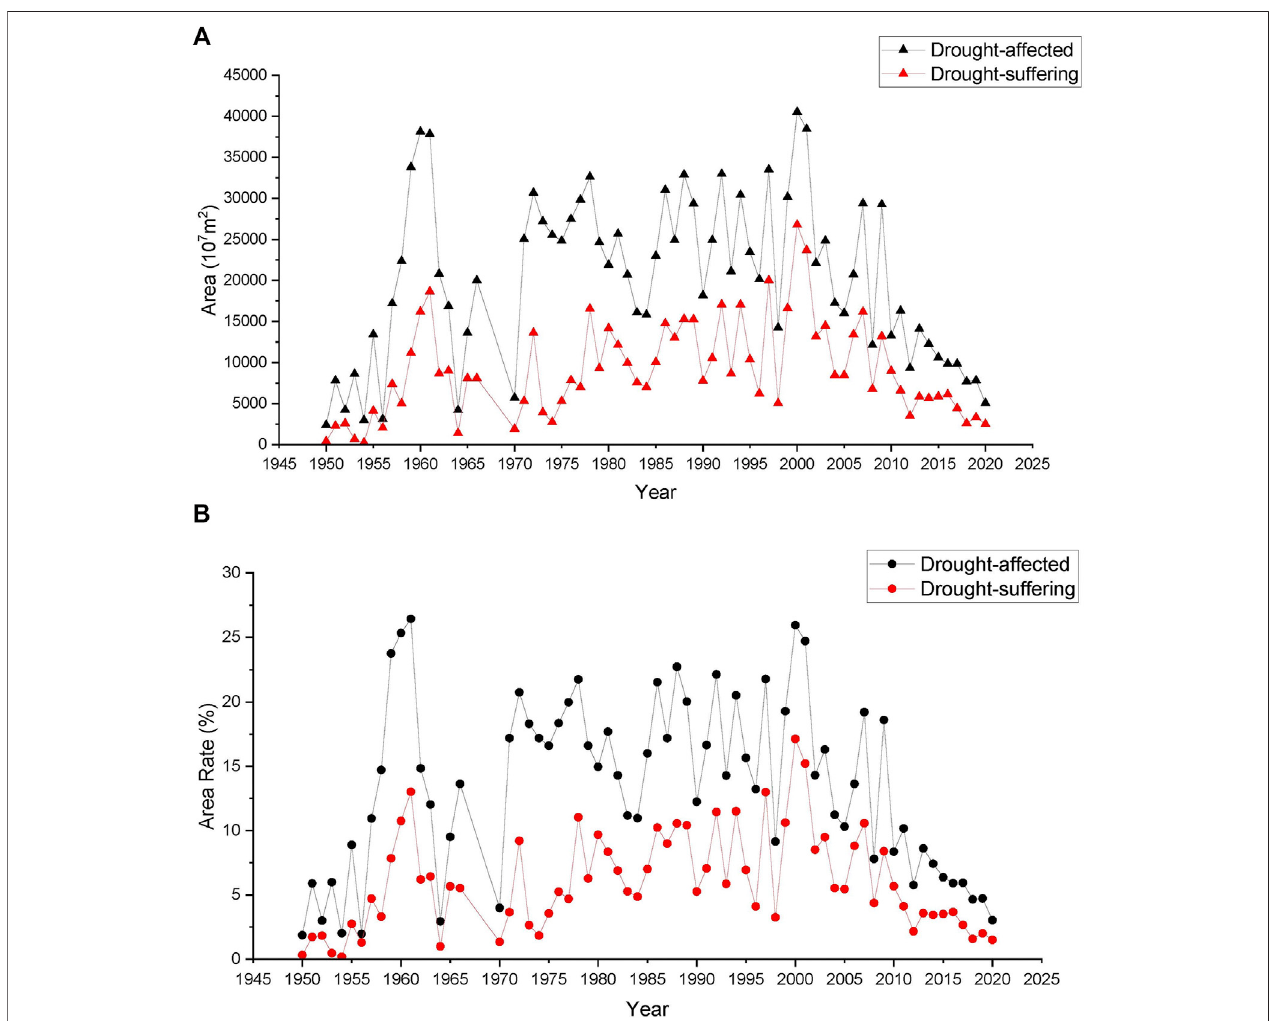
FIGURE 1 | Temporal variation of agricultural drought disasters in China from 1950 to 2020. (A) Drought-affected area and drought-suffering area. (B) Drought- affected area rate and drought-suffering area rate.